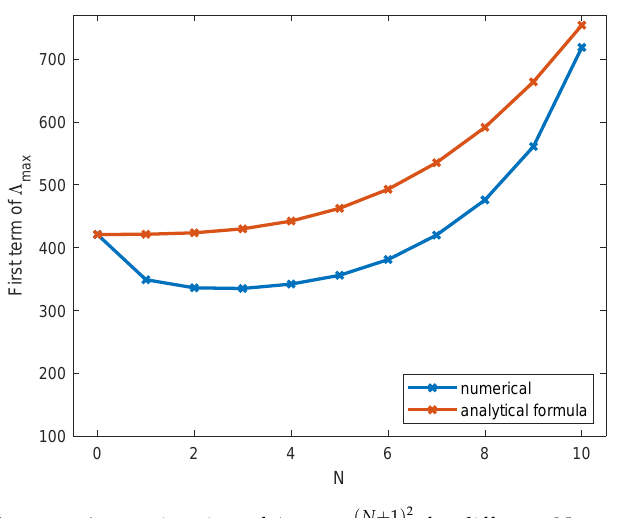
Figure 8. Approximation of Λ max − ( N + 1 ) calculated numerically (blue) and by using the analytical formula